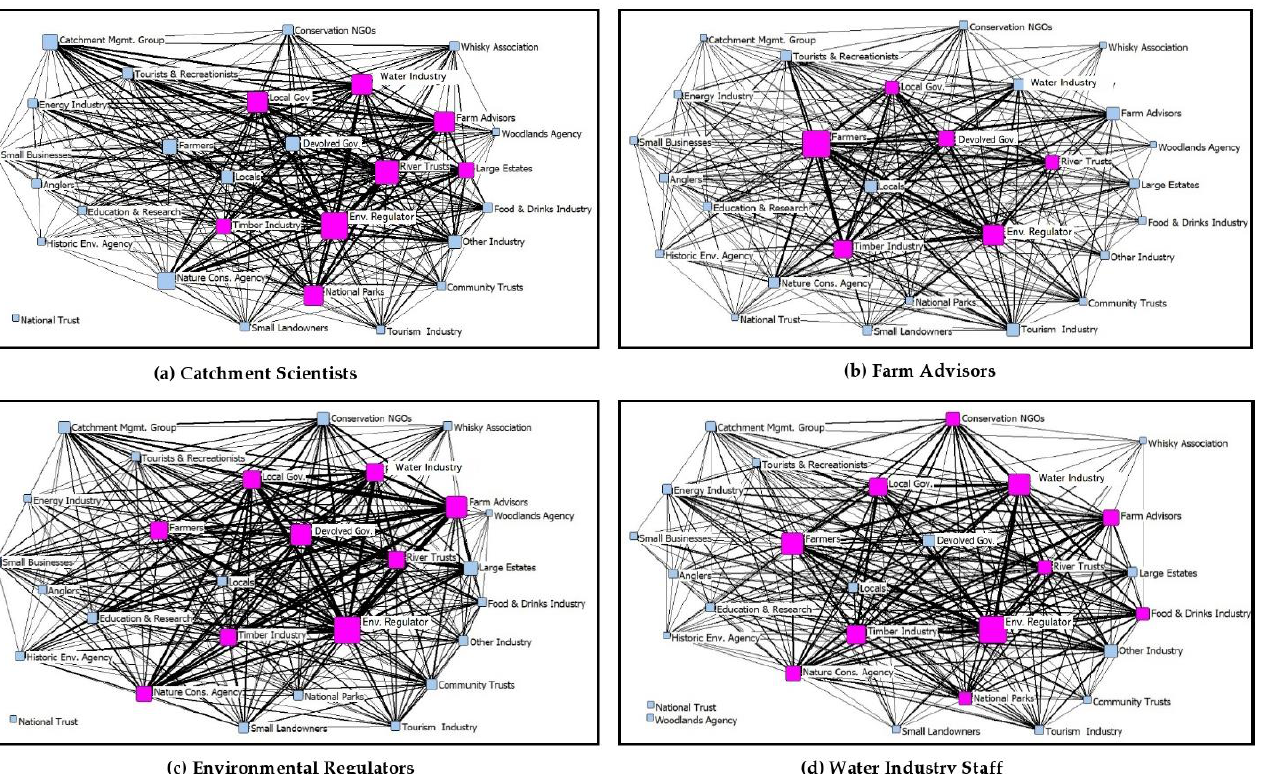
Figure 6. One-mode networks from the ( a ) Catchment Scientist, ( b ) Farm Advisor, ( c ) Environmental Regulator and ( d ) Water Industry Staff stakeholders. Node size depicts degree score and node colour the core (pink) and periphery (blue). Core/Periphery fit (correlation) = 0.864 (Catchment Scientists), 0.861 (Farm Advisors), 0.902 (Environmental Regulators) and 0.872 (Water Industry Staff).